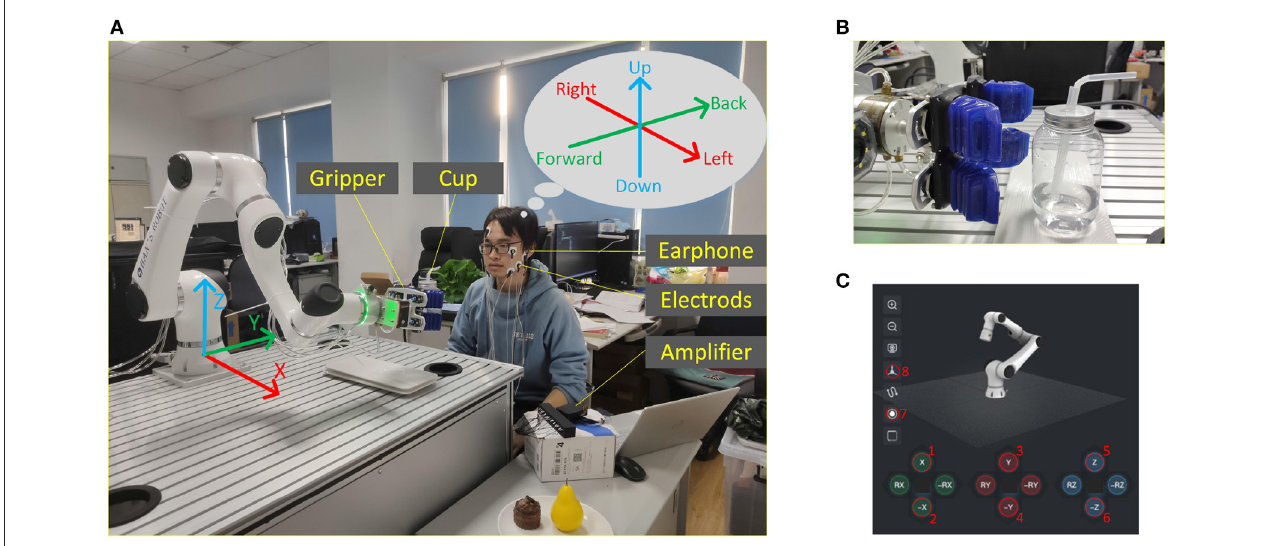
FIGURE 6 | Online control of robotic arm through fEMG. (A) A snapshot of the online control of the robotic arm to drink water. The robotic arm body and its coordinate system, the soft gripper, fEMG electrodes, earphone for audio feedback, amplifier, PC, etc. are marked. (B) A photo of the soft gripper before grabbing the cup. (C) Virtual button interface for manipulating the robotic